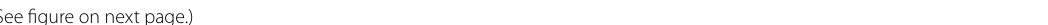
).(See figure on next Fig. 6 Field emission scanning electron images of composite material; a FESEM image of graphene-cement composite at 7 days; b Energy selective Backscattered (EsB) or backscattered image of ( a ); c EDX of graphene on a point indicated in ( a ); d EDX for the hydrated cement product at cross hair location in ( b ); e FESEM image of graphene-cement composite at 28 days; f EsB or backscattered image of ( e ); g EDX for the marked point in ( e ); and h EDX at cross-hair location in ( f